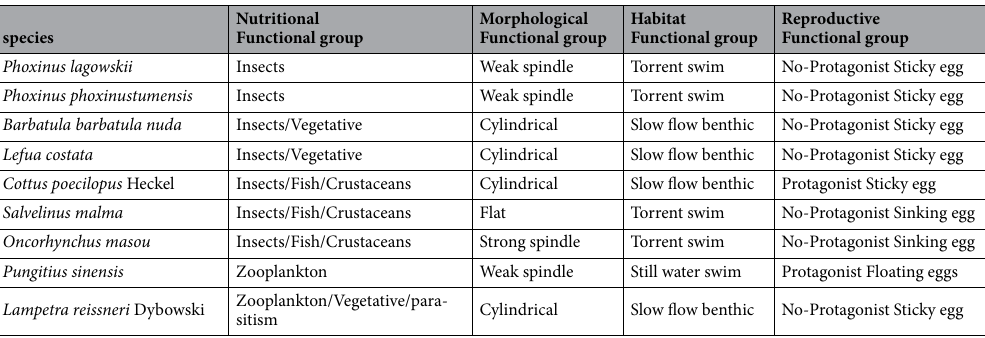
Table 3. The functional groups of fish assemblages in the Hunchun River